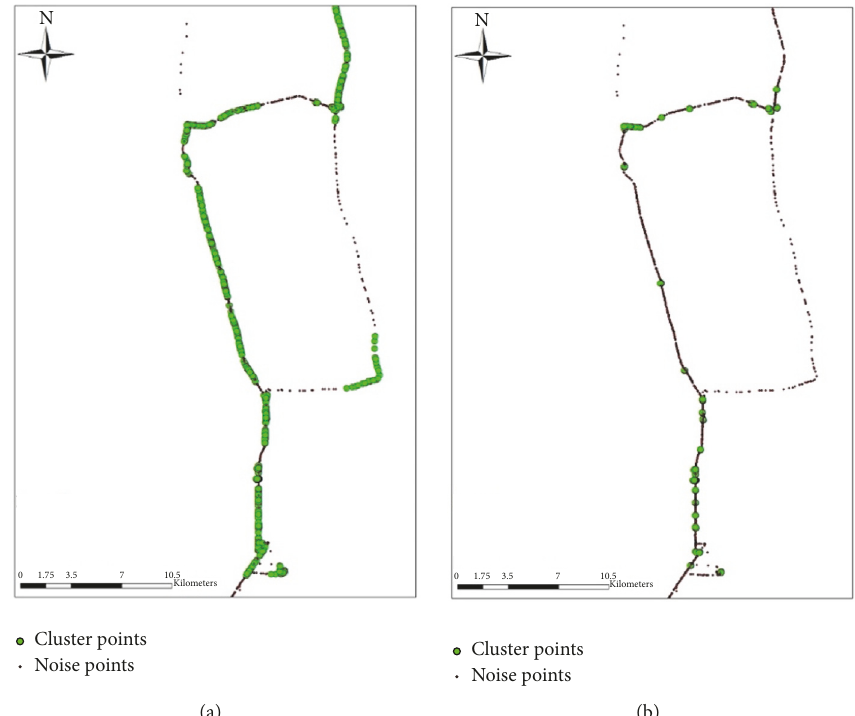
Figure 13: Clustering results of Sample Trajectory B by two algorithms: (a) HDBSCAN and (b)